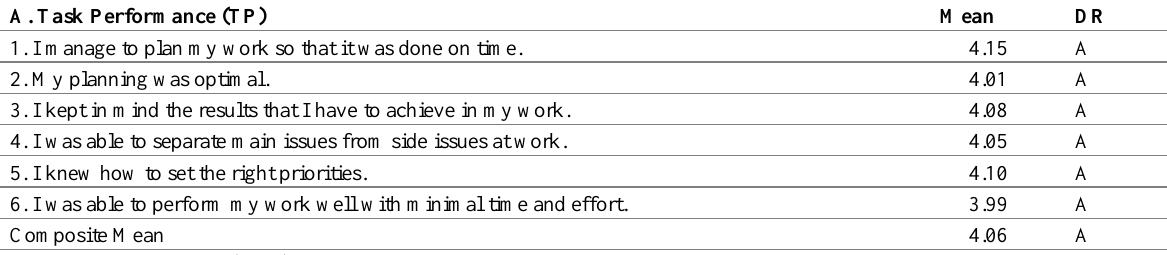
Table 2: Individual Work Performance of Employees of Divine Word Colleges in the Ilocos